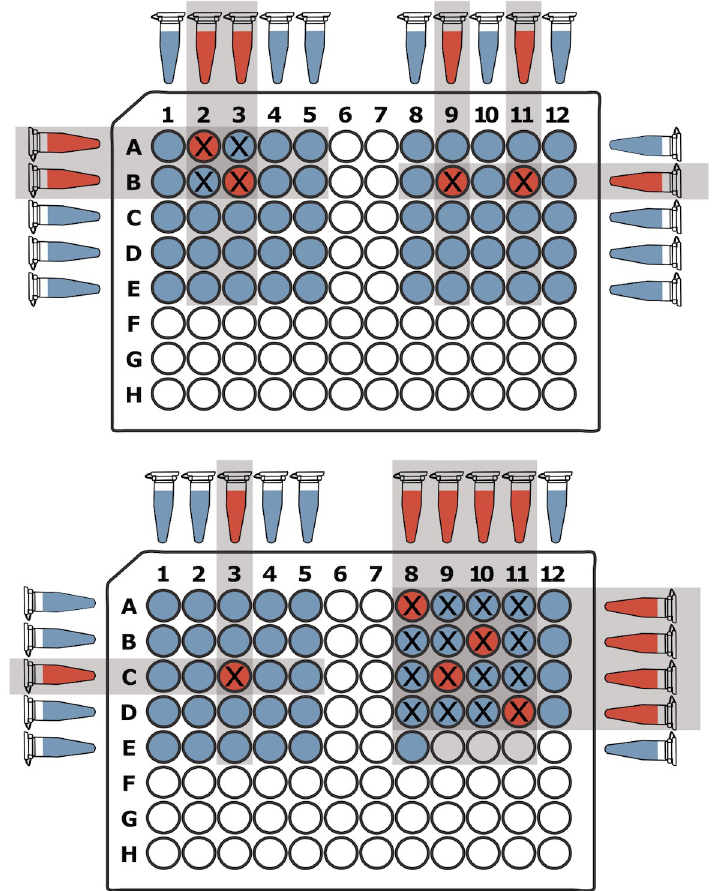
Fig 2. Two-Dimensional pooling example. A total of 96 samples are arrayed in symmetrical 5x5 grids (with 4 empty wells in the last grid) and k = 9 of the samples are positive (red wells). The pooling procedure combines each row and each column of a grid into separate pools for a total of T = 2 × 5 × 4 = 40 tests. Samples that are at the intersection of a positive row and a positive column (marked with an “X”) are potentially positive samples. When more than one row and more than one column are positive, some of the samples at the intersections are likely false positives (e.g. the top left and bottom right grids). Otherwise, the results are unambiguous and the correct positive samples can be identified (e.g. the top right and bottom left